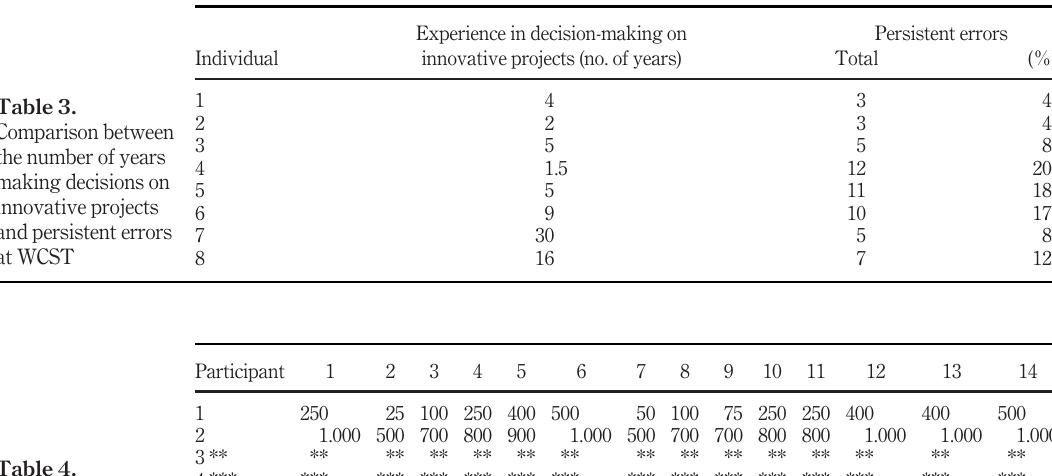
Table 4. Simulated decision- making (original results of the study)